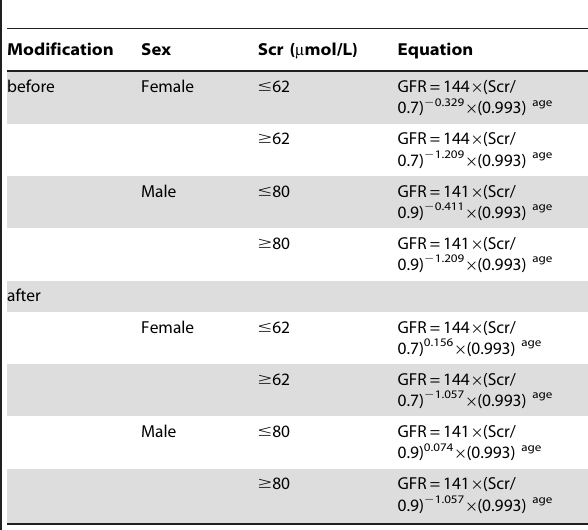
Table 2. The CKD-EPI equation before and after modification by mathematical algorithms.